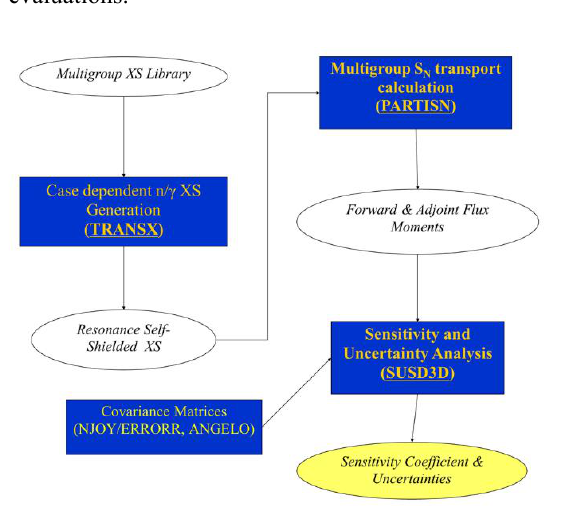
Fig. 1. XSUN computer code